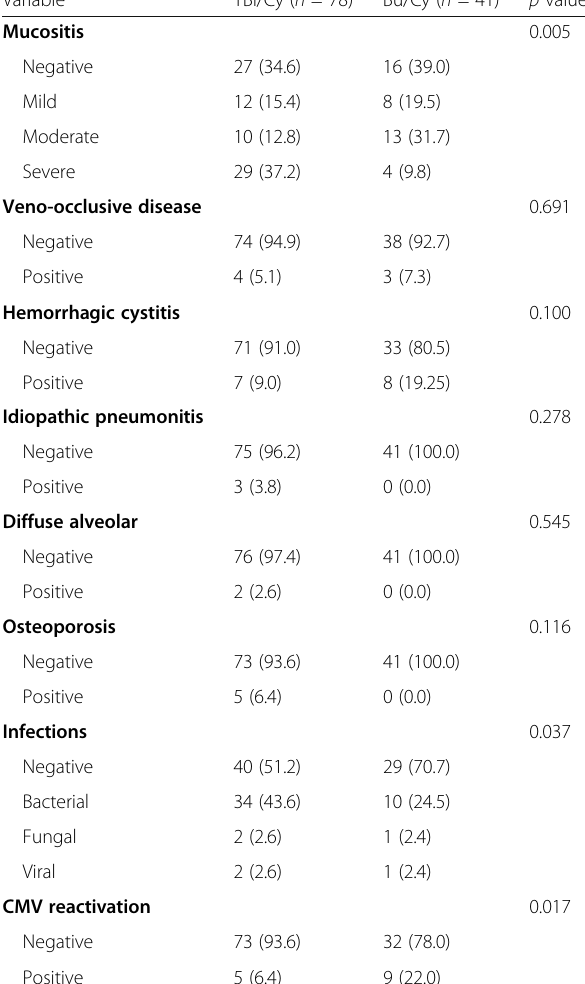
Table 6 Comparison between the studied groups according to regimen-related